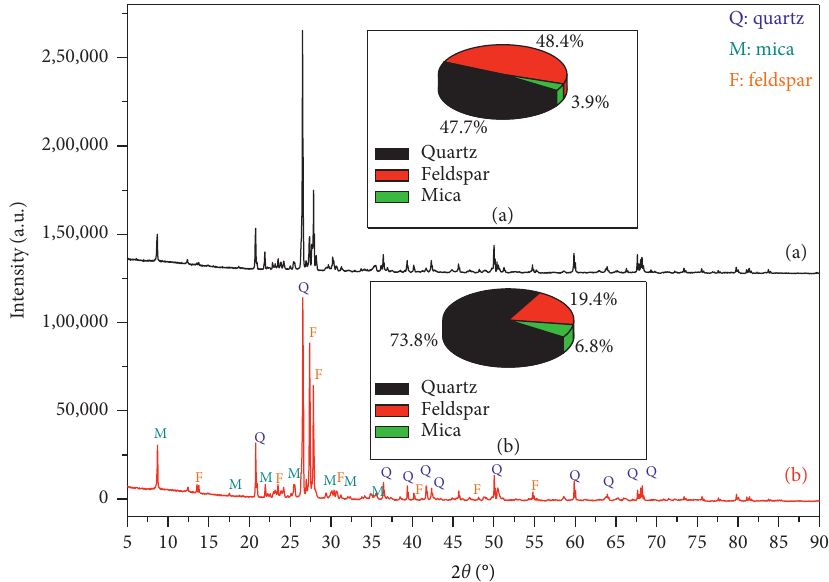
Figure 1: X-ray analysis of Rosa Porrino (a), Gris Pinhel (b), and mass fraction of